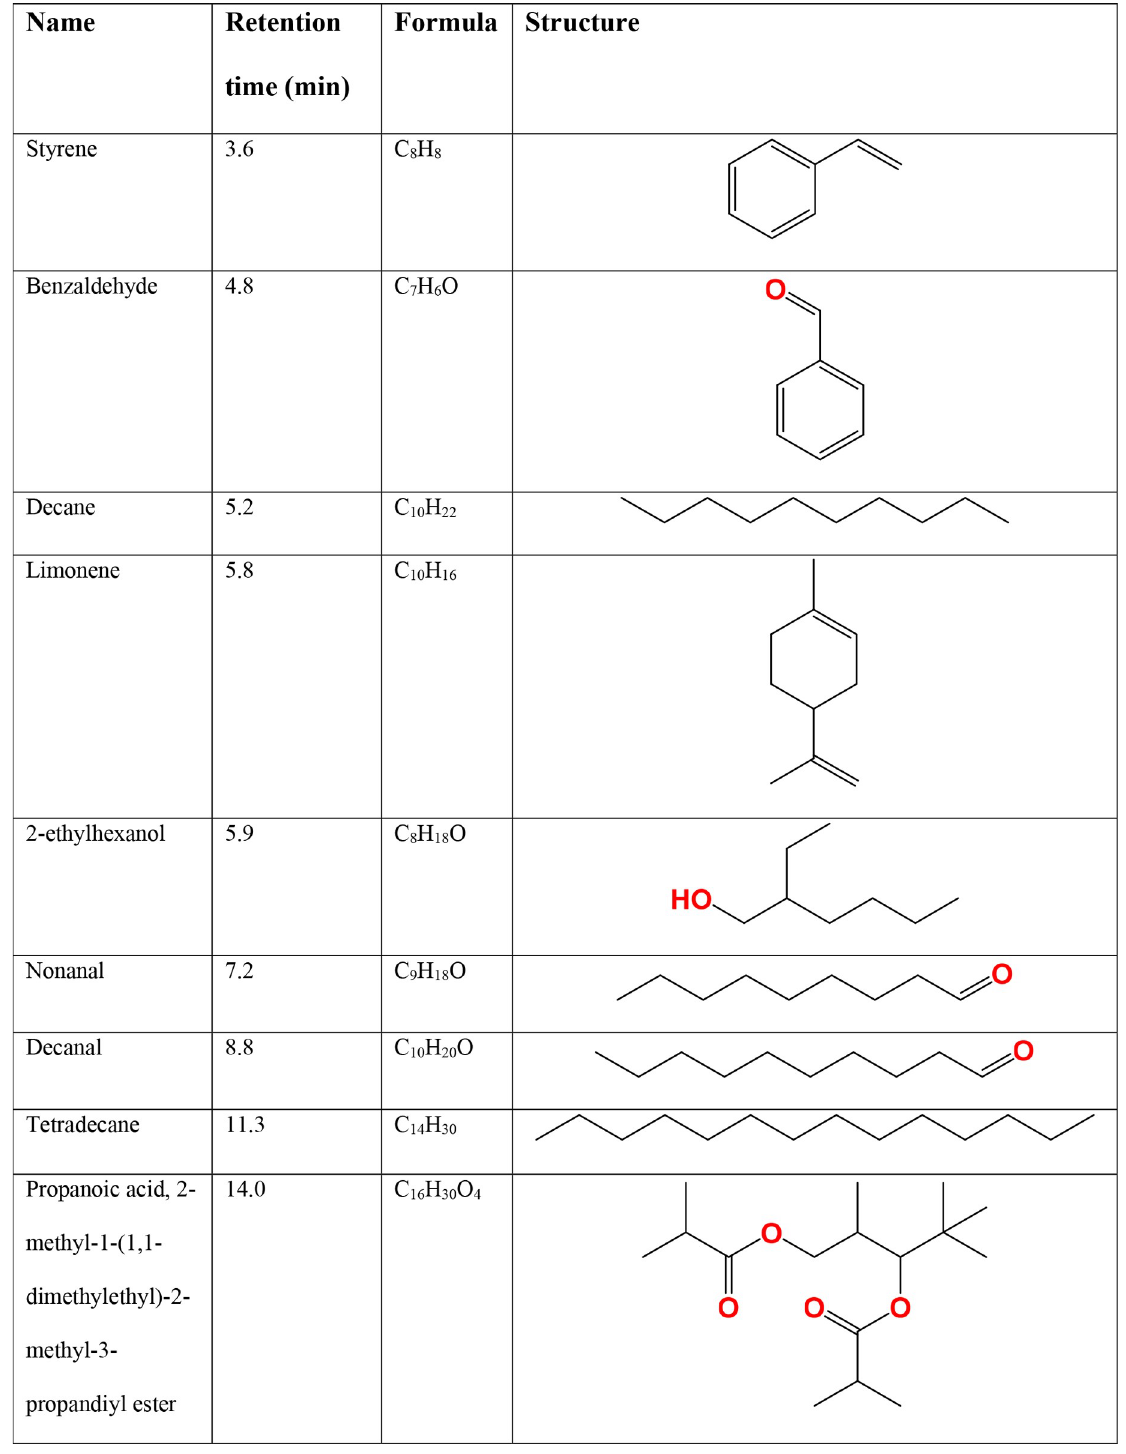
Fig 6. Most abundant VOCs detected in C . aspersum trail mucus.